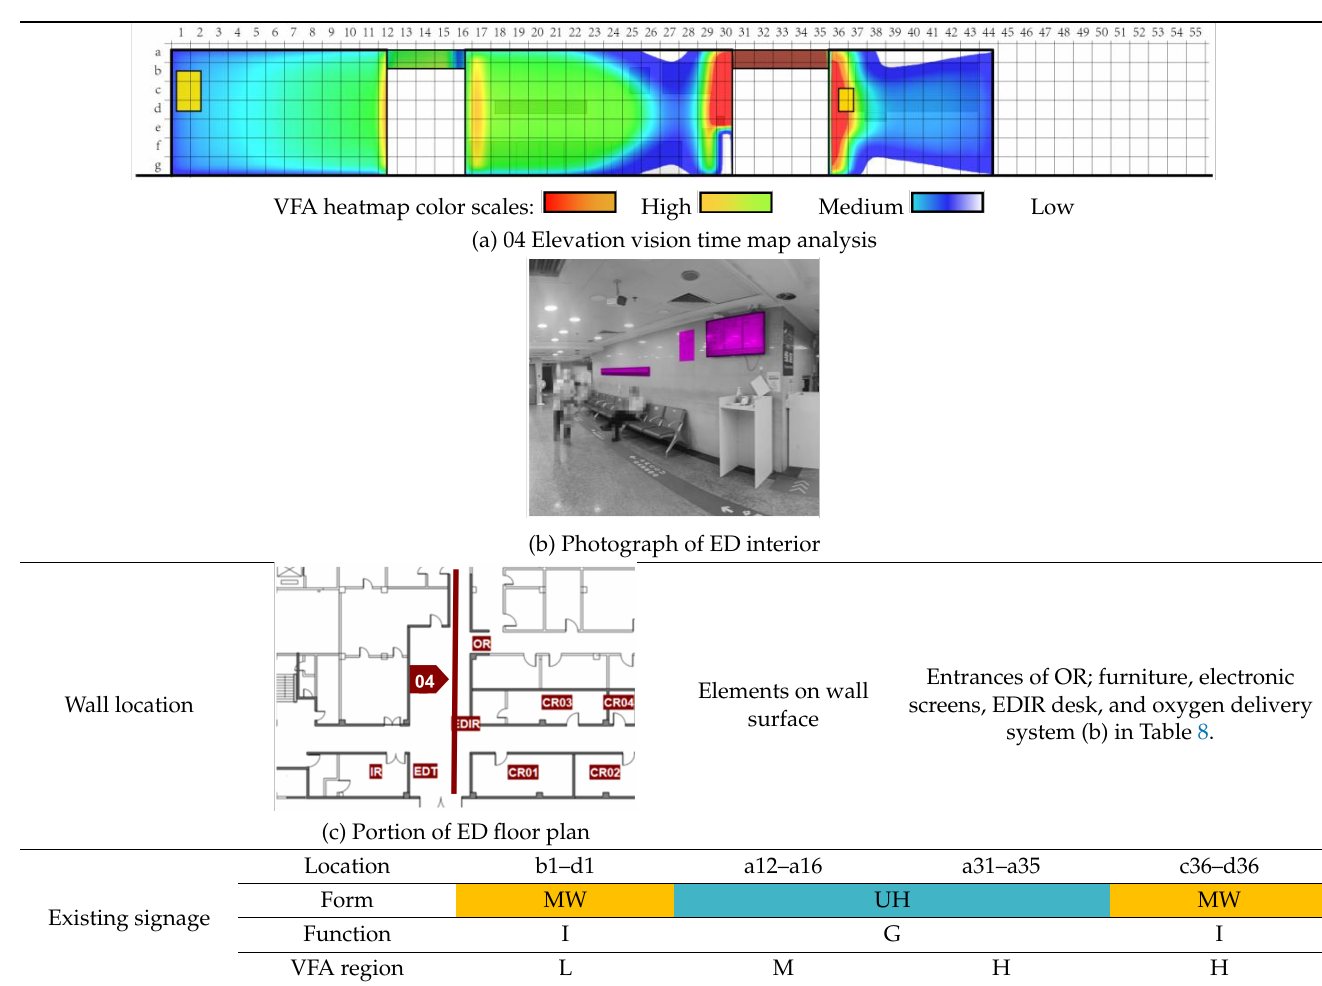
Table 8. 04 Elevation comparative